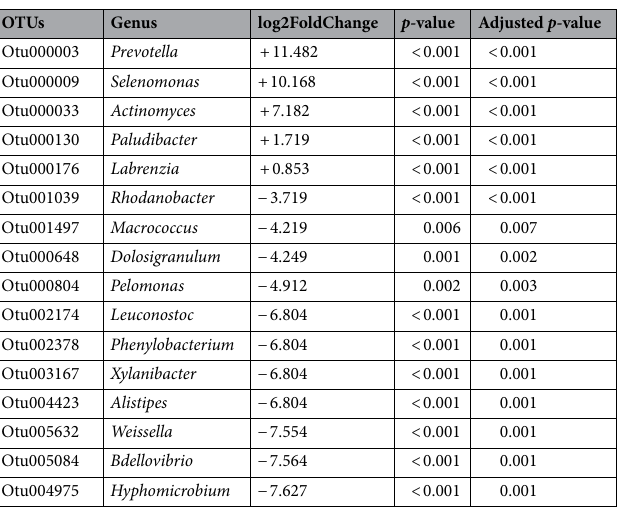
Table 4. List of differentially abundant genera in girls in caries group compared with cavity free group. log2FoldChange value (+) means higher and (–) means lower abundancy in caries group compared with cavity free